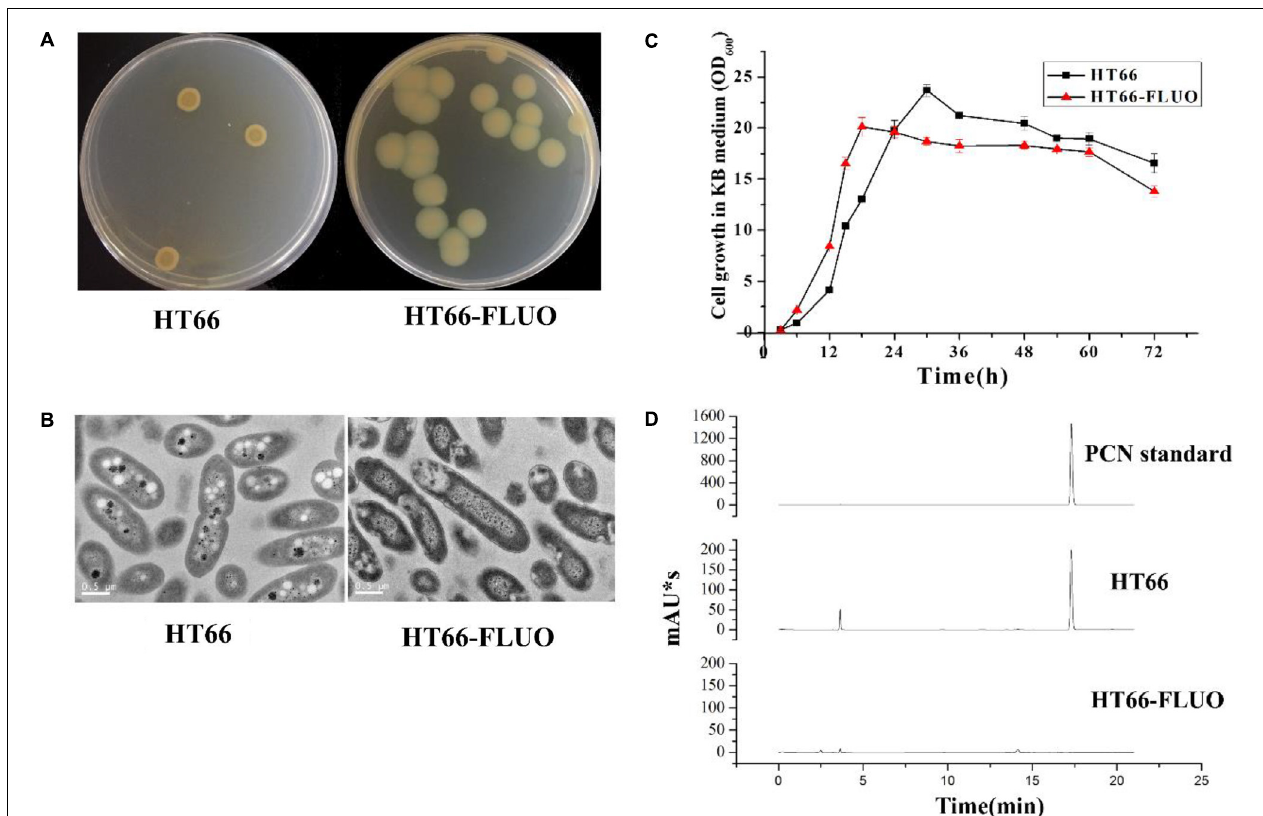
FIGURE 1 | The morphology, growth, and phenazine-1-carboxamide production of Pseudomonas chlororaphis HT66 and HT66-FLUO. (A) Comparison of single colony of HT66 and HT66-FLUO following the bacterial strains incubation on KB agar plates for 72 h. (B) Analysis of cell morphology of P. chlororaphis HT66 and HT66-FLUO by Transmission electron microscopy. (C) Growth curves of HT66 and HT66-FLUO grown in KB culture medium at 28 ◦ C and 180 rpm. (D) PCN production of P. chlororaphis HT66 and HT66-FLUO in HPLC analysis. The top is 72.5 mg/L PCN standard, Middle is the PCN production of P. chlororaphis HT66 and Bottom is the PCN production of mutant strain HT66-FLUOin KB broth at 28 ◦ C with 180 rpm for 60